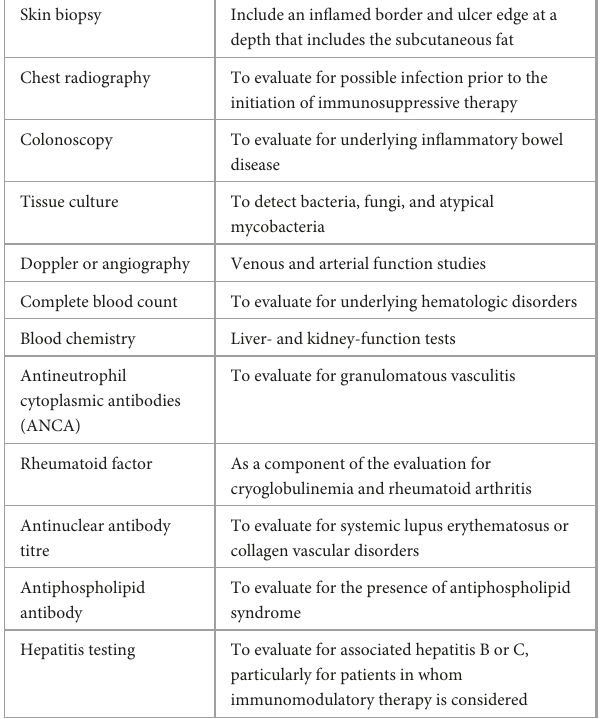
TABLE 3 Recommendations for the laboratory tests (20, 26, 37, 42). Skin